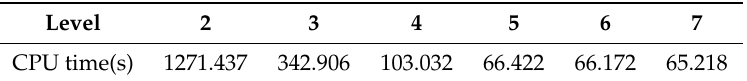
Table 5. Numbers of multigrid levels and CPU times required until tolerance different levels are used.